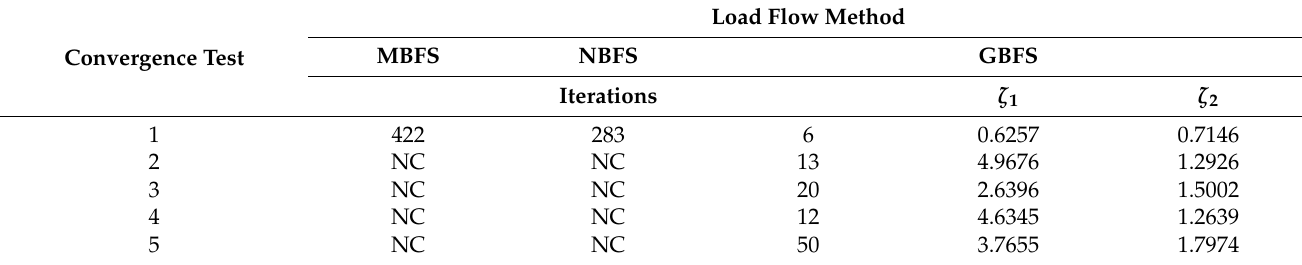
Table 6. Number of load flow iterations for the six-bus system considering tests of Table